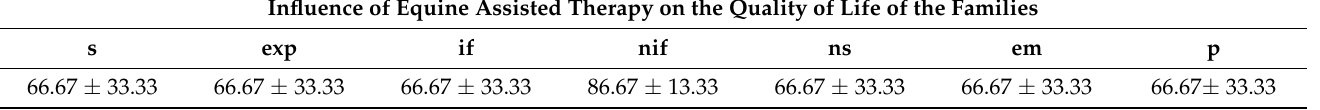
Table 8. Mean values ± SEM of improvement percentage of different parameters related to the quality of life of the families. These parameters were collected from the surveys that were filled out by the families of the patients after 9–10 sessions of equine assisted